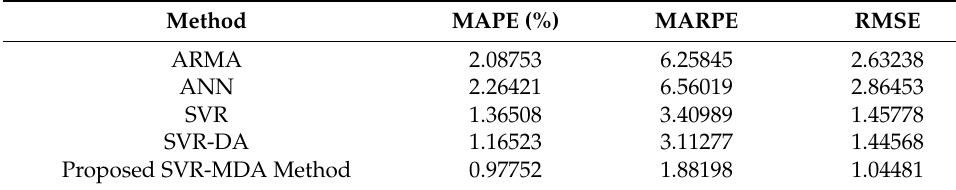
Table 6. Forecasting total charging demand of HEVs using different